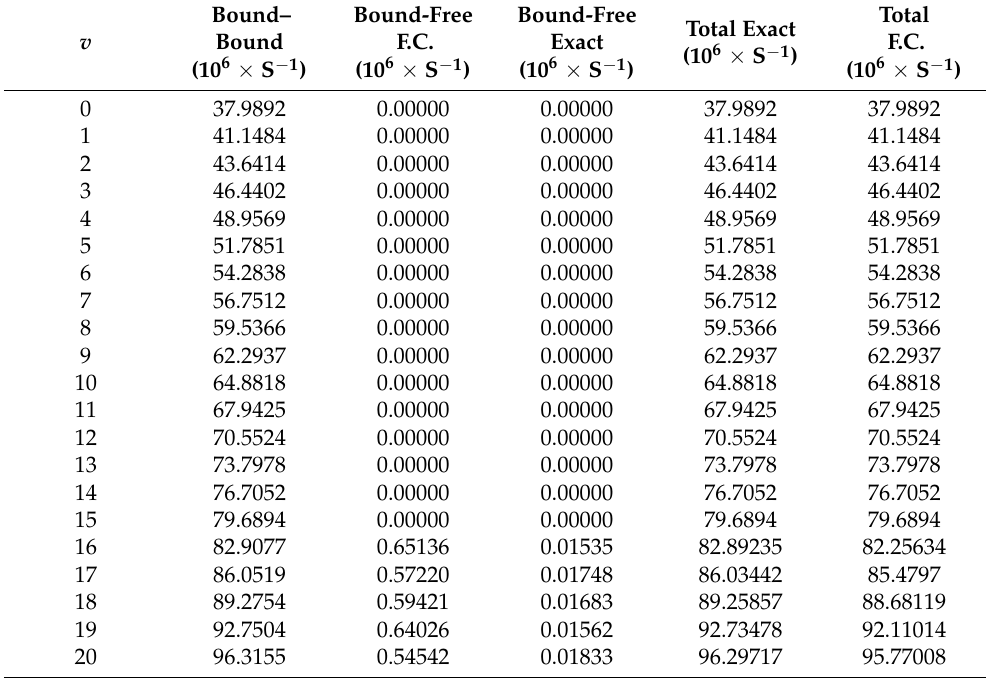
Table 3. Radiative lifetimes associated with the C → A emission of the ion (SrK) +